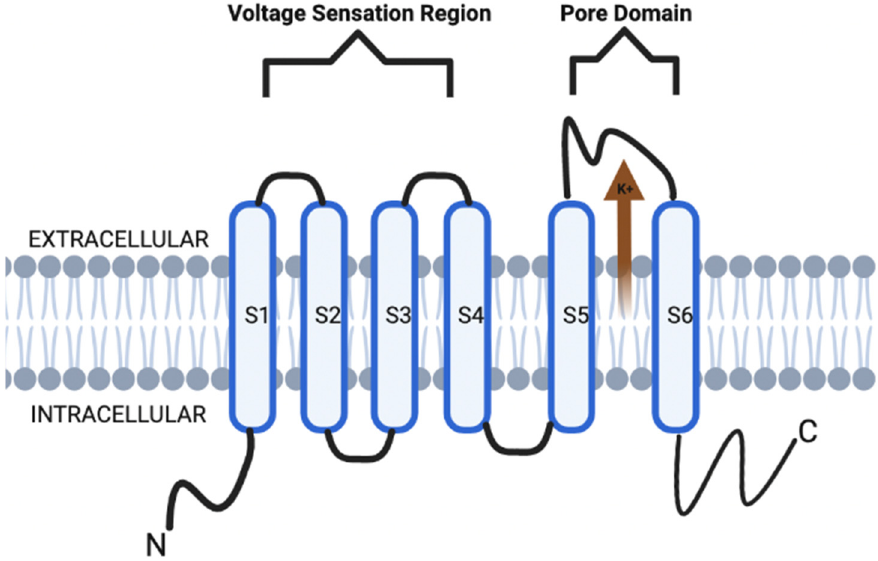
Figure 1. KCNQ channel structure is composed of six transmembrane segmental helices, classified as S1–S6. In addition, the S1–S4 transmembrane segmental helices compose the actual voltage sensation region, and the latter two (S5–S6) units are the actual gate of the channel. Table 1. Expression distribution and associated pathologies with channel genes.